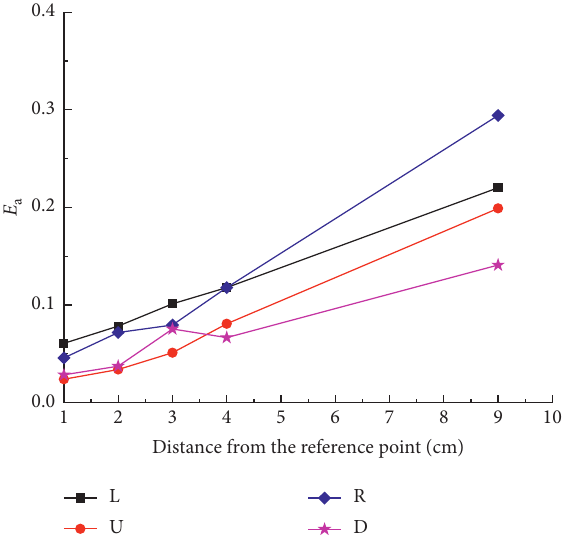
Figure 8: E a of various